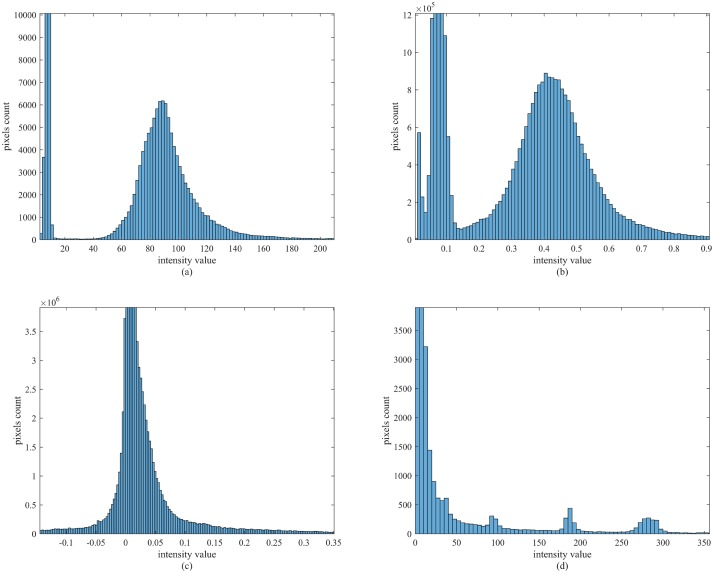
Histogram based visual representation of the applied preprocessing contrast enhancement schemes.(a) Green channel image (b) CLAHE (c) TopHat image (d) Frangi enhanced image.